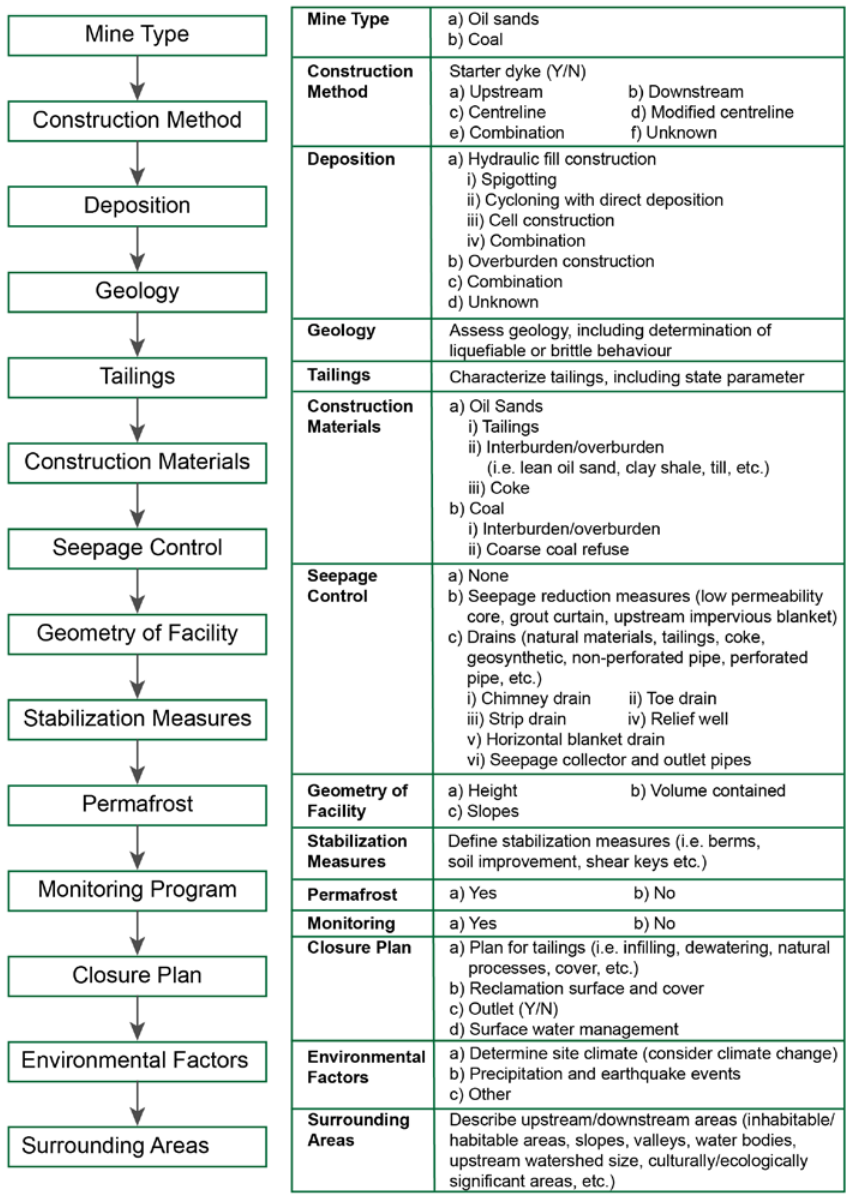
Figure 2. System definition of oil sand and coal mines in Alberta, Canada.